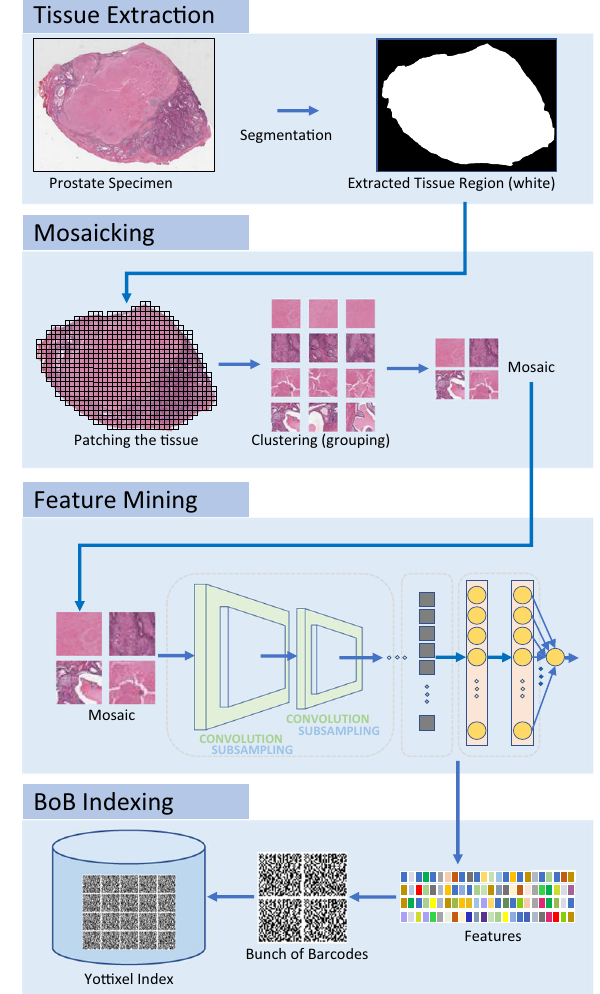
Fig. 9 Yottixel image search engine: whole-slide images are segmented fi rst to extract the tissue region by excluding the background (top block). A mosaic of representative patches (tiles) is assembled through grouping of all patches of the tissue region using an unsupervised clustering algorithm (second block from the top). All patches of the mosaic are fed into a pretrained arti fi cial neural network for feature mining (third block from the top). Finally, a bunch of barcodes is generated and added to the index of all WSI fi les in the archive (bottom